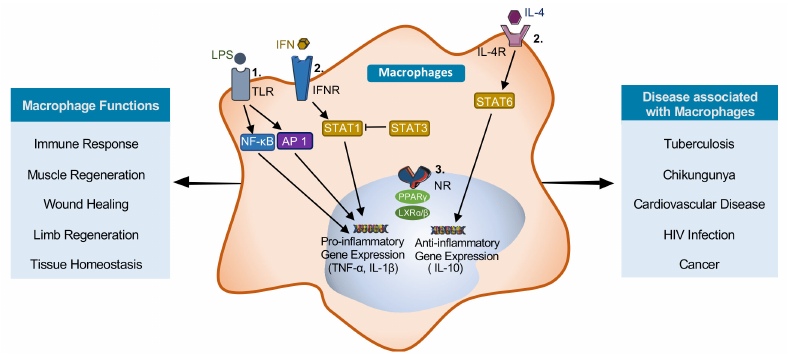
Figure 1. Macrophage: polarization, function, and associated diseases. Three main families of receptors regulate macrophage polarization and function. These are (1) the toll-like receptors (TLRs) that signal through nuclear factor kappa-light-chain-enhancer of activated B cells (NF κ B) and AP-1, (2) the interferon receptor (IFNR) and interleukin (IL)-4 receptors that signal through signal transducer and activator of transcriptions (STATs), and (3) the nuclear receptors. Macrophage stimulated with lipopolysaccharide (LPS) and/or interferon-gamma (IFN γ ) polarize to pro-inflammatory (M1) macrophages. Stimulation with IL4 induce polarization to anti-inflammatory (M2) macrophages. Regulation is important for proper physiological responses; however, dysregulation can contribute to the pathogenesis of